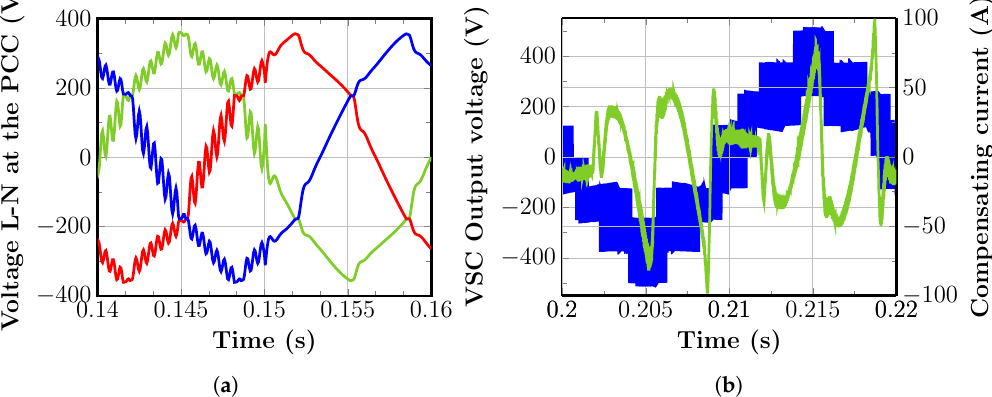
Figure 12. ( a ) V PCC behavior in presence of the 3L-TNPC-based VSAPF. ( b ) 3L-TNPC-based VSAPF compensating current I C for the phase A (green) and converter output voltage v o-N for the same phase.